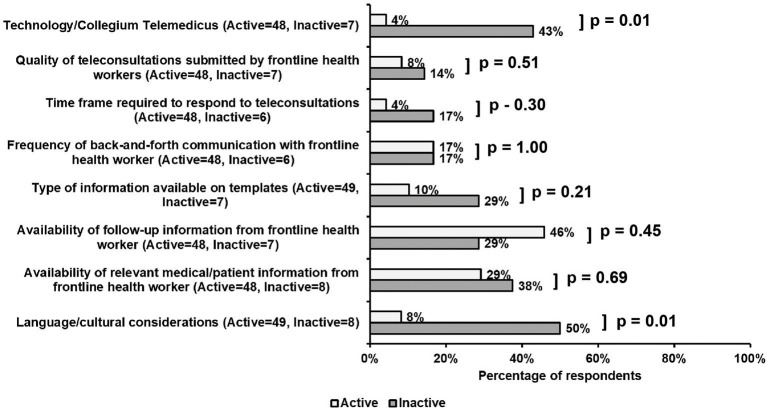
Survey responses regarding perceived obstacles to the teleconsultation process. Noteworthy and significant differences between active and inactive participants included difficulties with language/cultural considerations (8 vs. 50%, p = 0.01), and the telemedicine platform interface (4 vs. 43%, p = 0.01). Active respondents also found the availability of follow-up (46%) and relevant medical (29%) information from FHWs as obstacles to the teleconsultation process. Features of work-flow were not viewed as an obstacle by a majority of either cohort.